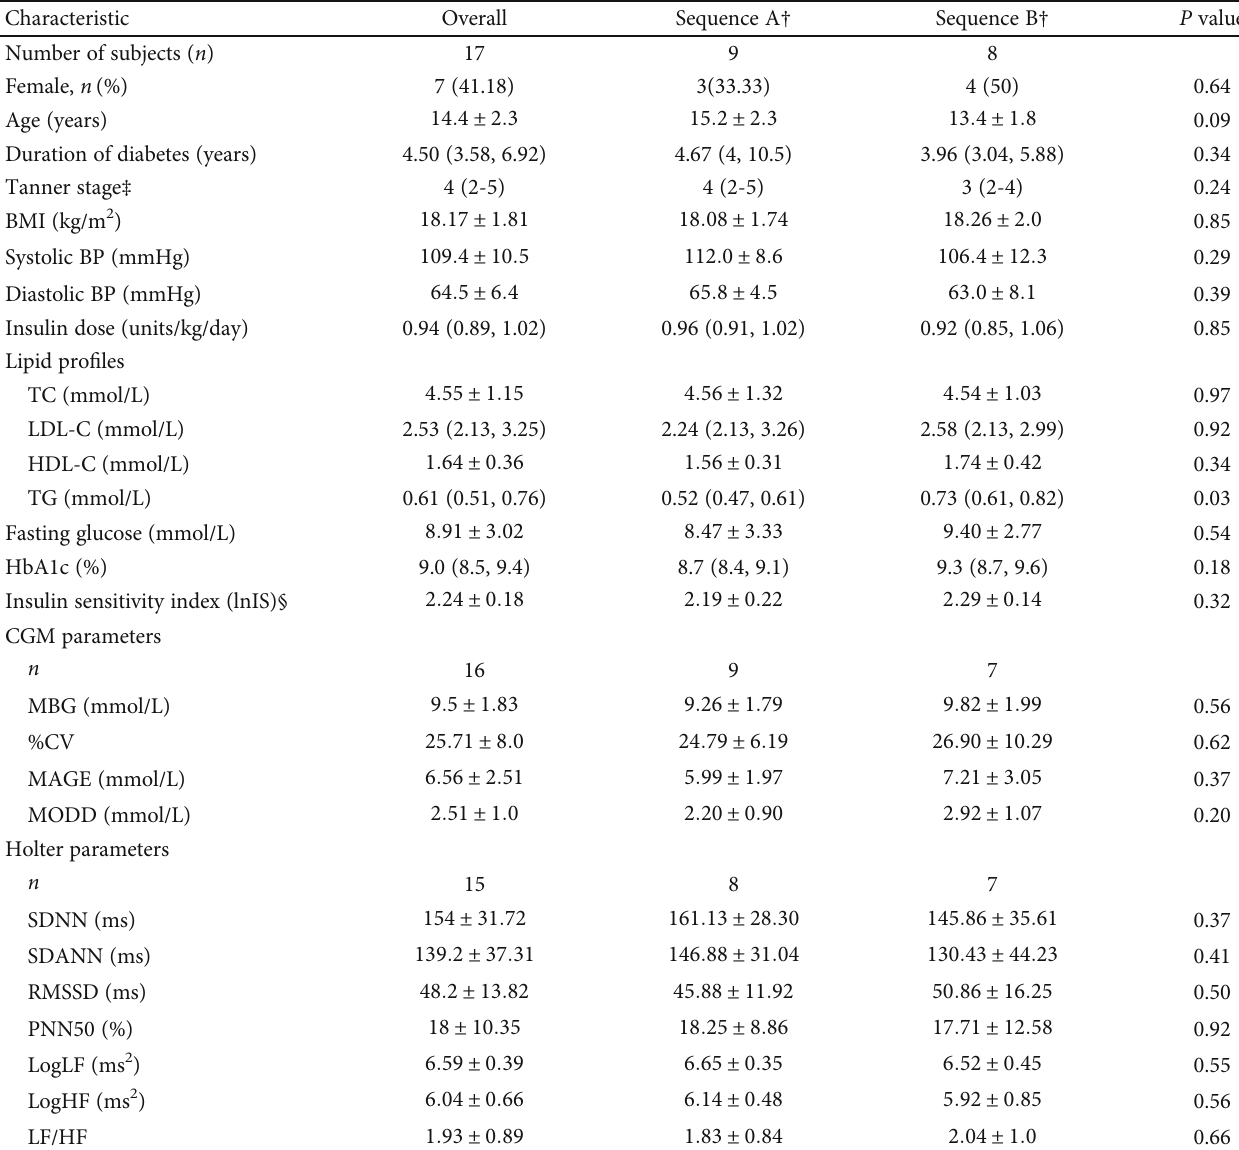
Table 1: Baseline characteristics of the randomized